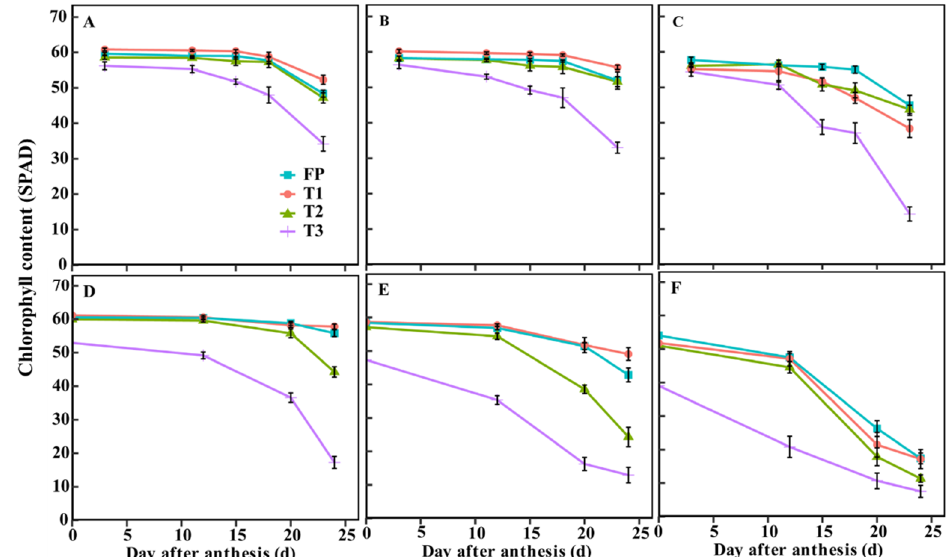
Figure 5. Chlorophyll content (SPAD) of the flag leaf ( A and D ), the second leaf ( B and E ), and the third leaf ( C and F )